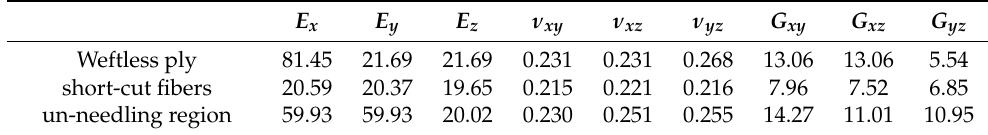
Table 2. Predicted material elastic properties (unit of elastic modulus and shear modulus: GPa).